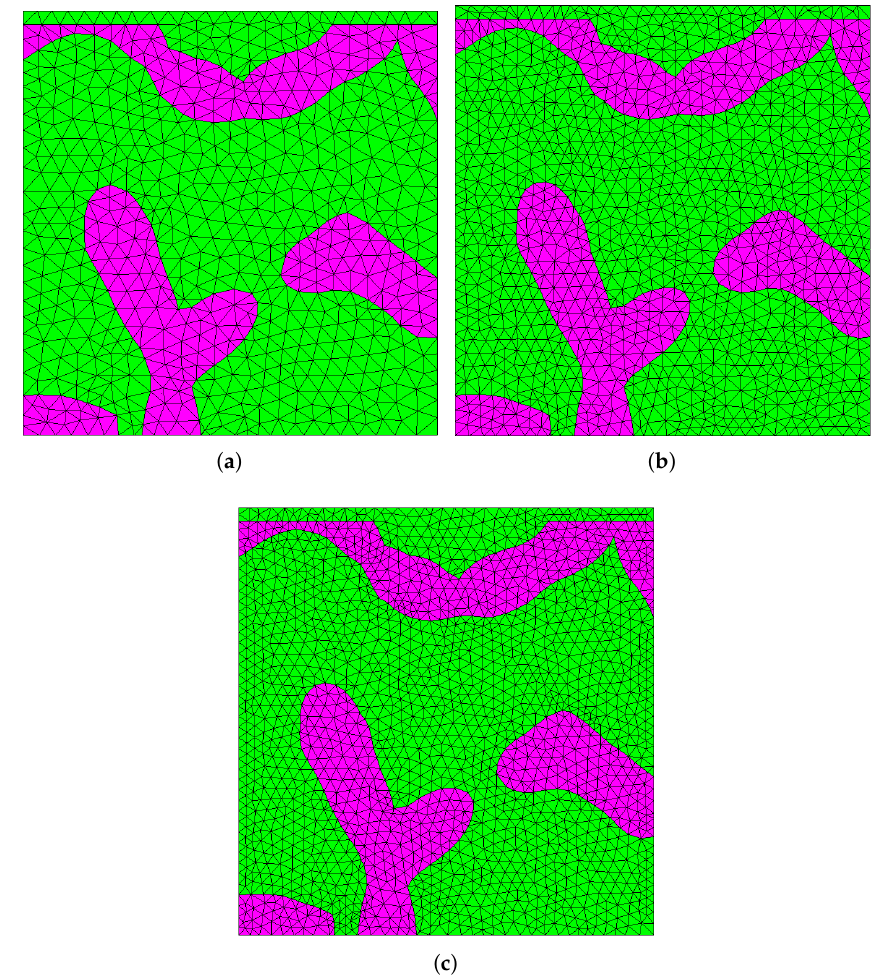
Figure 6. Illustration of the RVE meshed with ( a ) 173,769 elements, ( b ) 405,042 elements and ( c ) 750,416 elements.